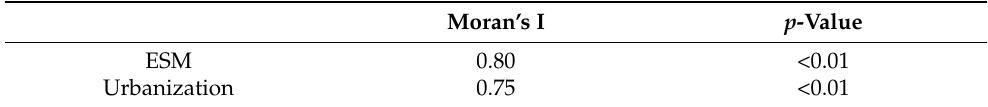
Table 3. Moran’s I statistics of ecosystem service multifunctionality (ESM) and urbanization.